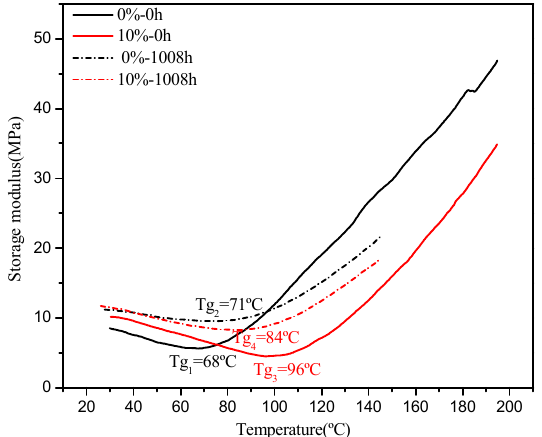
Figure 15. DMA test results before and after 1008 h high moisture ageing test.